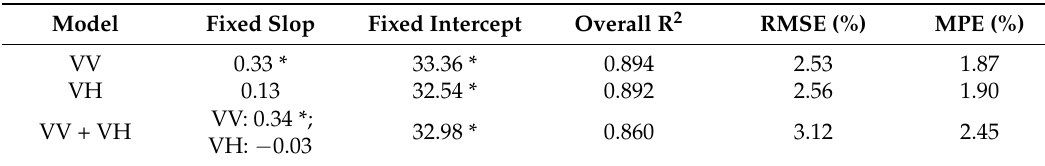
The calibrated parameters and performance statistics for three LME models with different